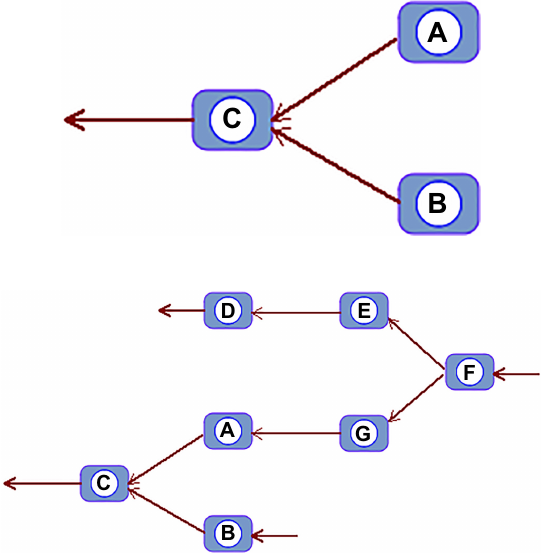
Figure 5. Basic analysis